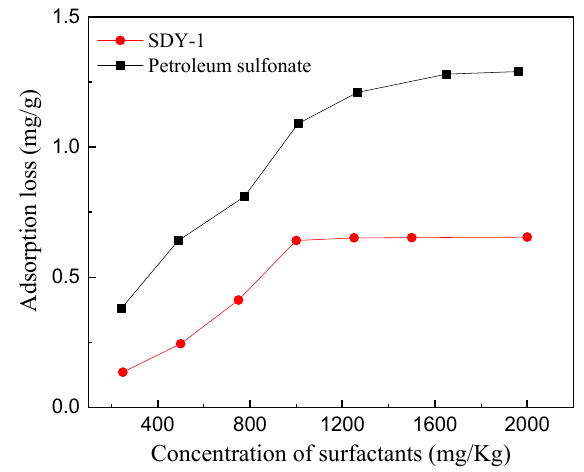
Figure 13. The adsorption isotherm curve of SDY-1 on the surface of rock.